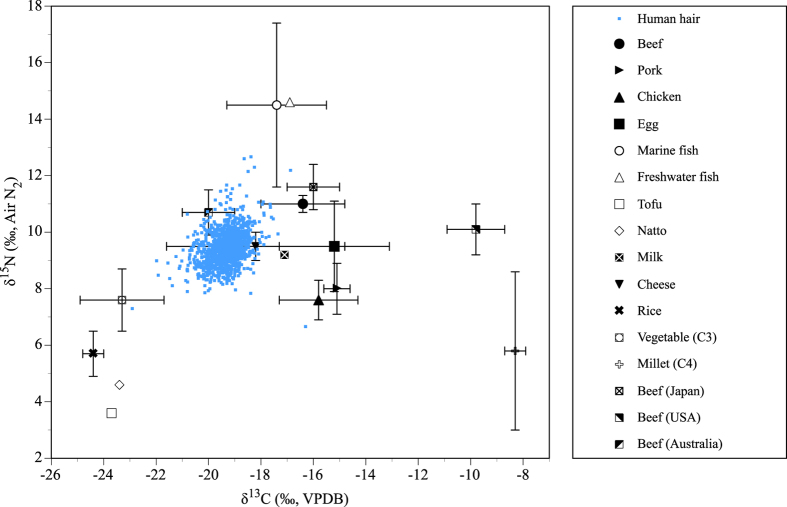
Carbon and nitrogen isotope ratios of hair samples from contemporary Japanese donors and food samples.The isotope enrichment values, that is, the difference in values between food and human hair (2.5‰ for δ13C, and 4.1‰ for δ15N), were added to the isotopic values of food samples19.